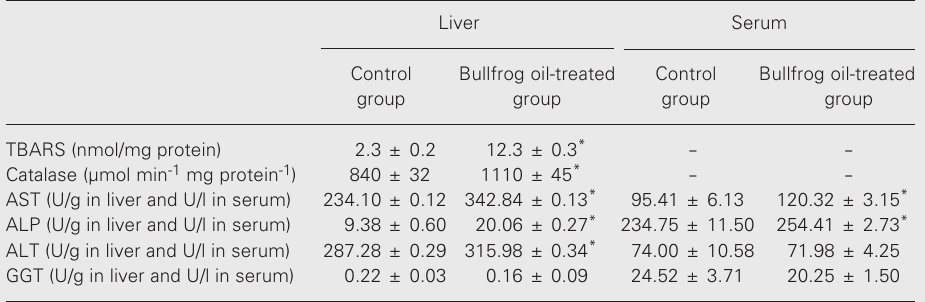
Table 2. Effect of intragastric bullfrog oil administration on TBARS, catalase, alkaline phosphatase, and aminotransferase activities of mouse liver and serum. Bullfrog oil administration is described in the legend to Table